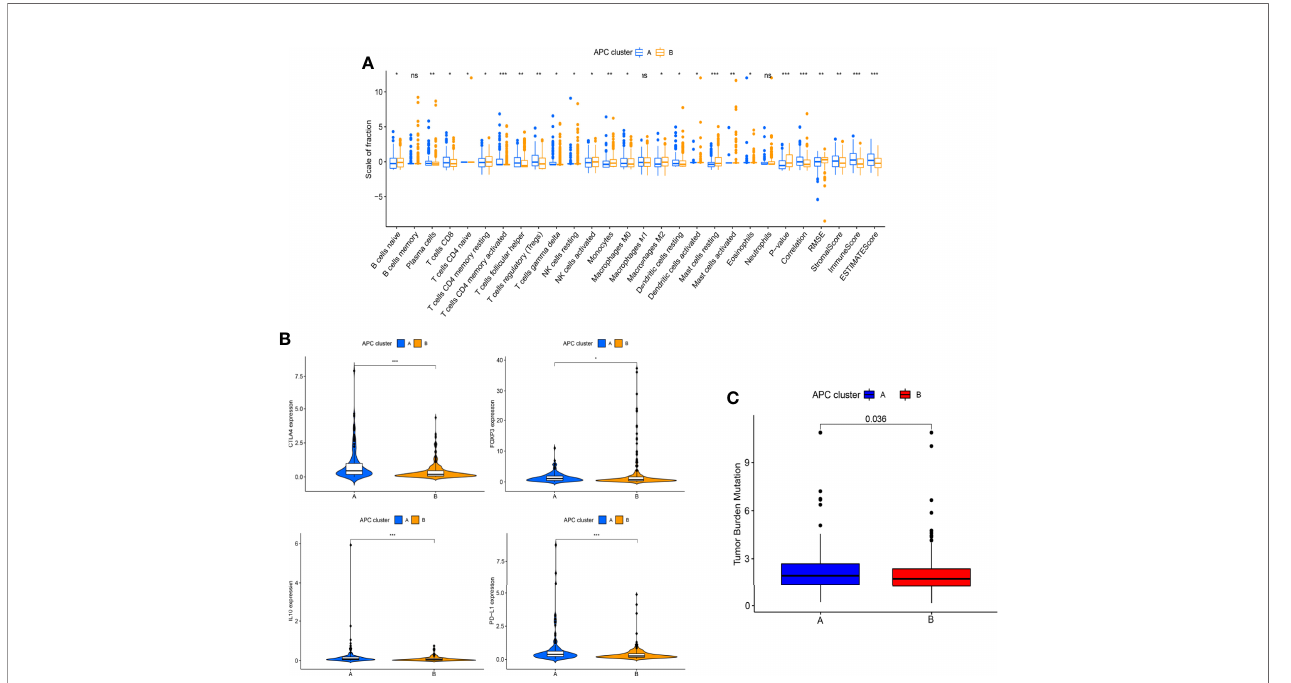
FIGURE 4 | Differences in immune in fi ltration levels between different antigen-presenting cell (APC) clusters. (A) The boxplot shows the difference between 22 tumor-in fi ltrating immune cells (TICs) and ESTIMATE scores between different APC clusters. (B) Difference in the expression of 4 immune checkpoint between different APC clusters (*p < 0.05, **p < 0.01, ***p < 0.001). (C) Difference in tumor mutational burden (TMB) between different APC clusters (p = 0.036). ns, no signi fi